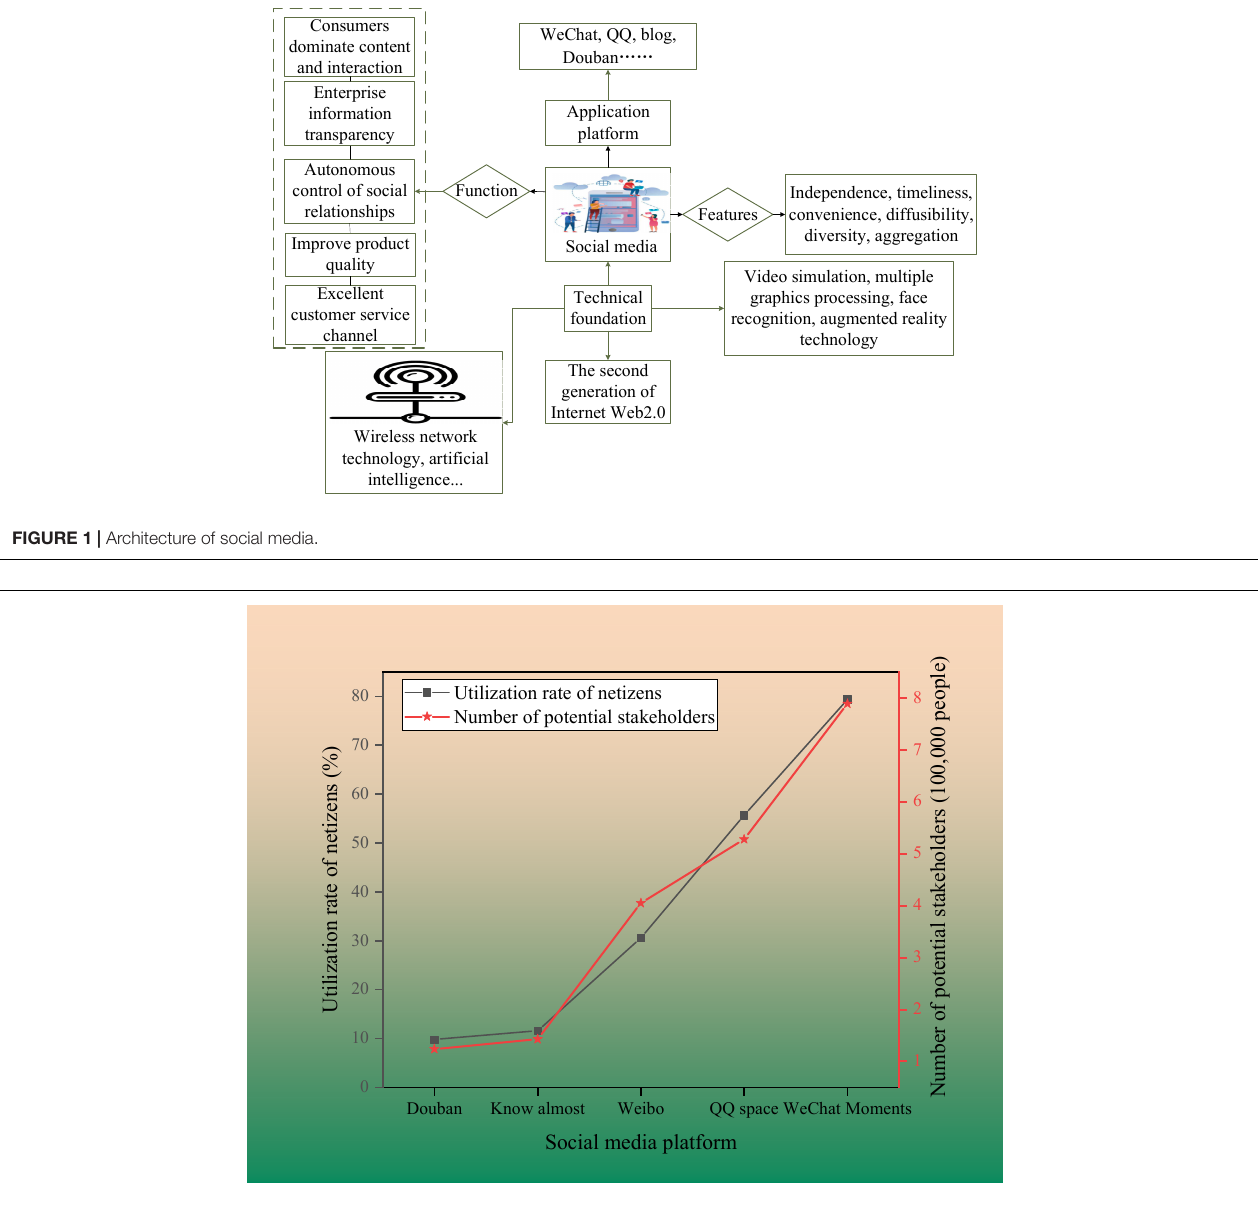
FIGURE 2 | Impact of different social media account platforms on CSR